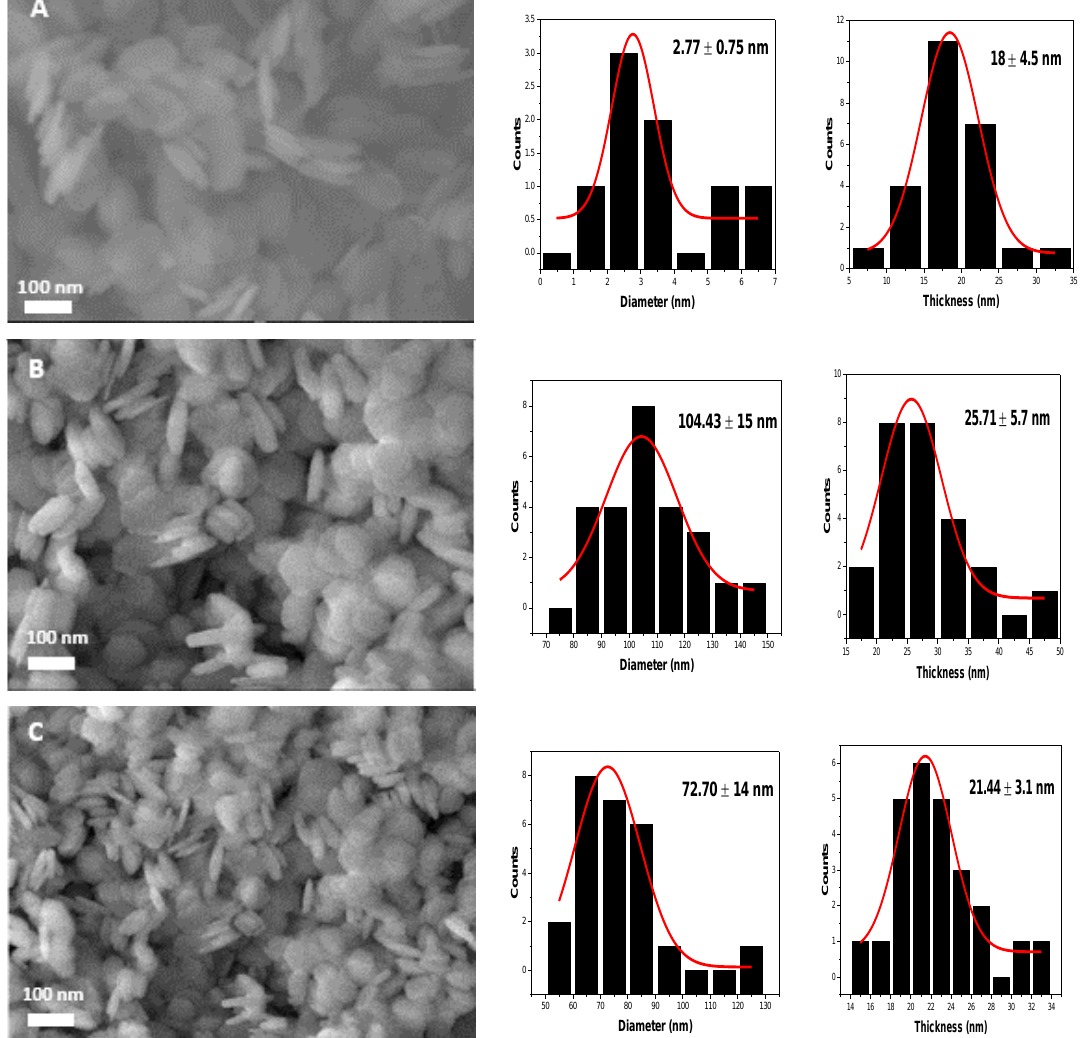
Figure 4. SEM images and particle size distribution analysis for all the investigated samples: ( A ) MgAl layer double hydroxide (LDH), ( B ) CoMgAl-LDH, and ( C ) CoAl-LDH samples. Energy-dispersive spectroscopy (EDS) analyses show pure materials free from any sodium ions with a stoichiometric ratio matching the calculated molar ratios of different cations. EDS analyses confirm the presence of cobalt cations in the chemical structure of the meixnerite phase, detected by XRD analysis. The absence of any diffraction peaks for cobalt compounds in the XRD analysis confirm the uniform isomorphic substitution of magnesium ions by cobalt ions in the cationic sheets (Table 1). Table 1. Data obtained from EDS analysis for all the investigated samples.